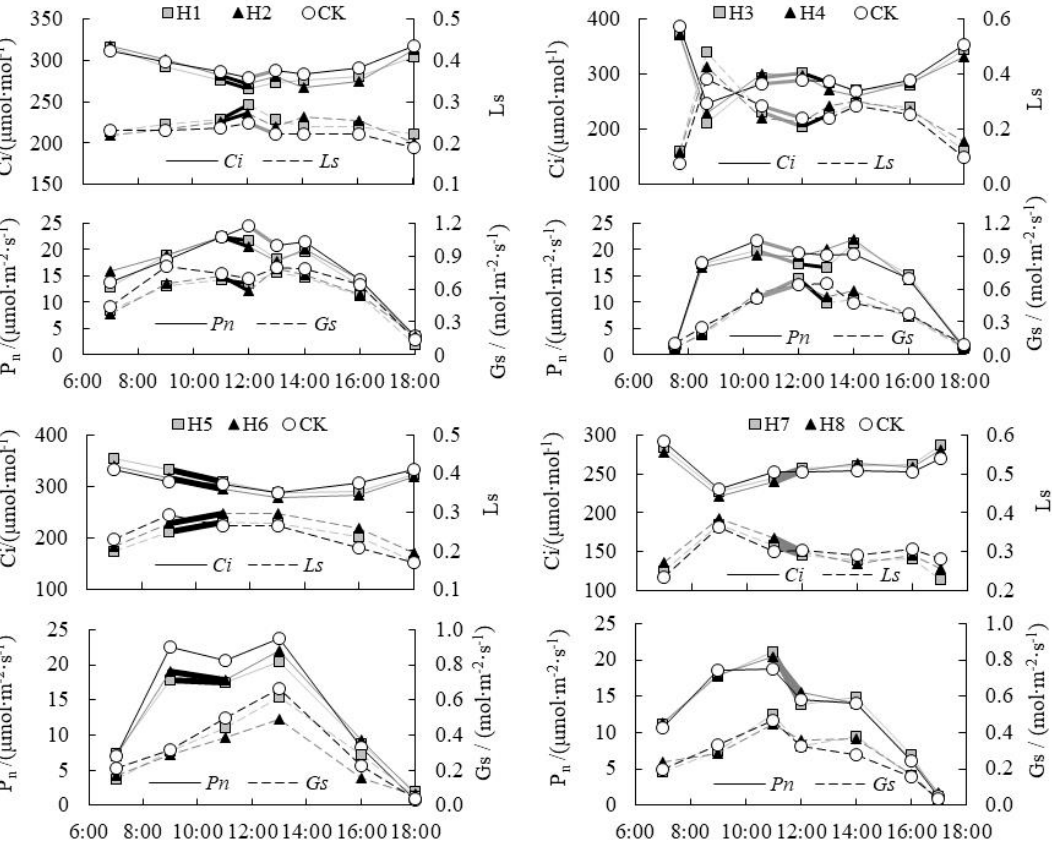
Figure 1. Stomatal and non-stomatal limitations relations on photosynthetic rate (Pn) under the drought condition.